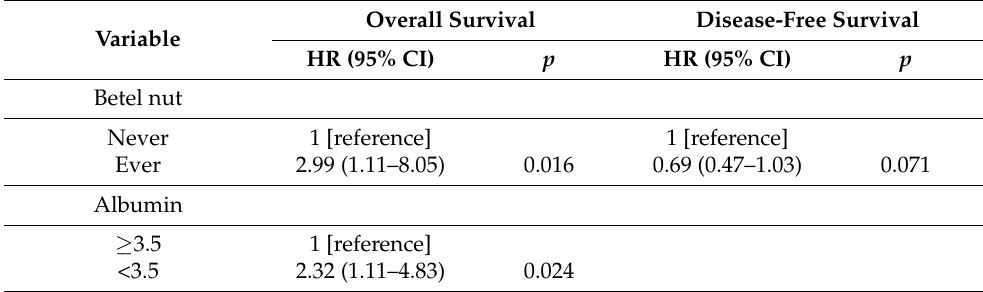
Table 5. Multivariate analysis of prognostic factors of overall survival and disease-free survival using Cox regression